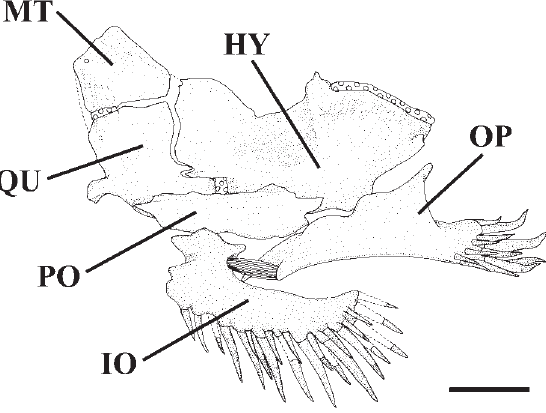
Fig. 6. Left suspensorium and opercular series of Tricho- mycterus maracaya (LIRP 4381), 43.9 mm SL, paratype. Lateral view. Abbreviations: HY, hyomandibula; IO, interopercle; MT, metapterygoid; OP, opercle; PO, preopercle; QU, quadrate. Scale bar = 1 mm.